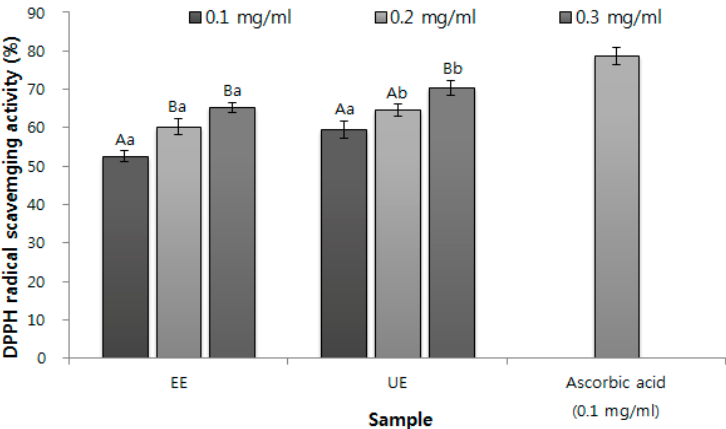
Figure 3. DPPH ( α , α -diphenyl- β -picrylhydrazyl) radical scavenging activities of E. prostrata L. extracts according to two different extraction processes. Mean values ± SD from triplicate separated experiments are shown. Means with different letters (A–B) within the same sample are significantly different at p < 0.05, and means with different letters (a–b) within the same concentration are significantly different at p < 0.05. (1) EE: 70% ethanol extraction at 80 °C, (2) UE: ultrasonic extraction with 70% ethanol at 40 °C.